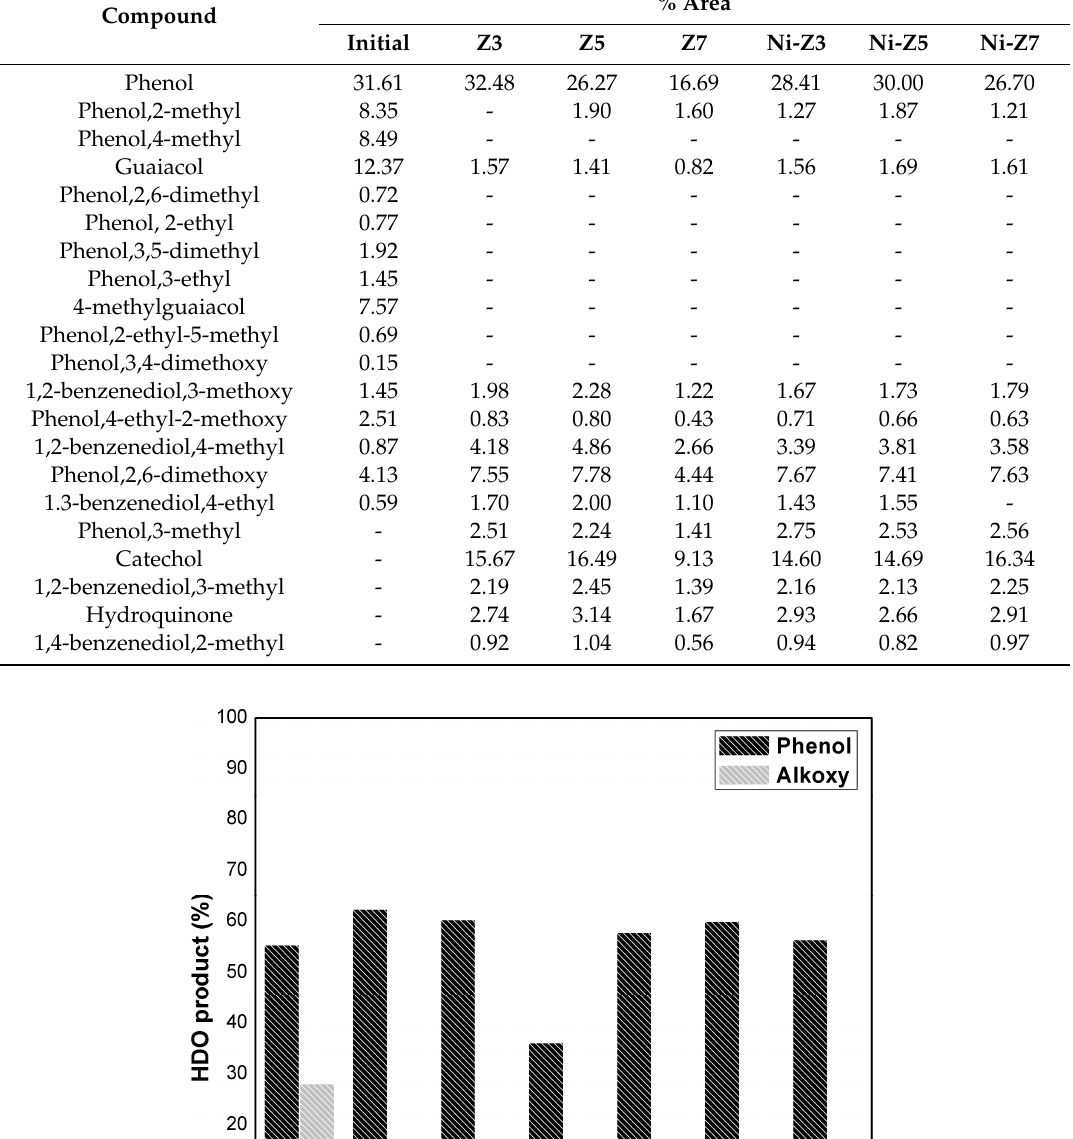
Table 9. Main components in commercial and HDO liquid smoke.